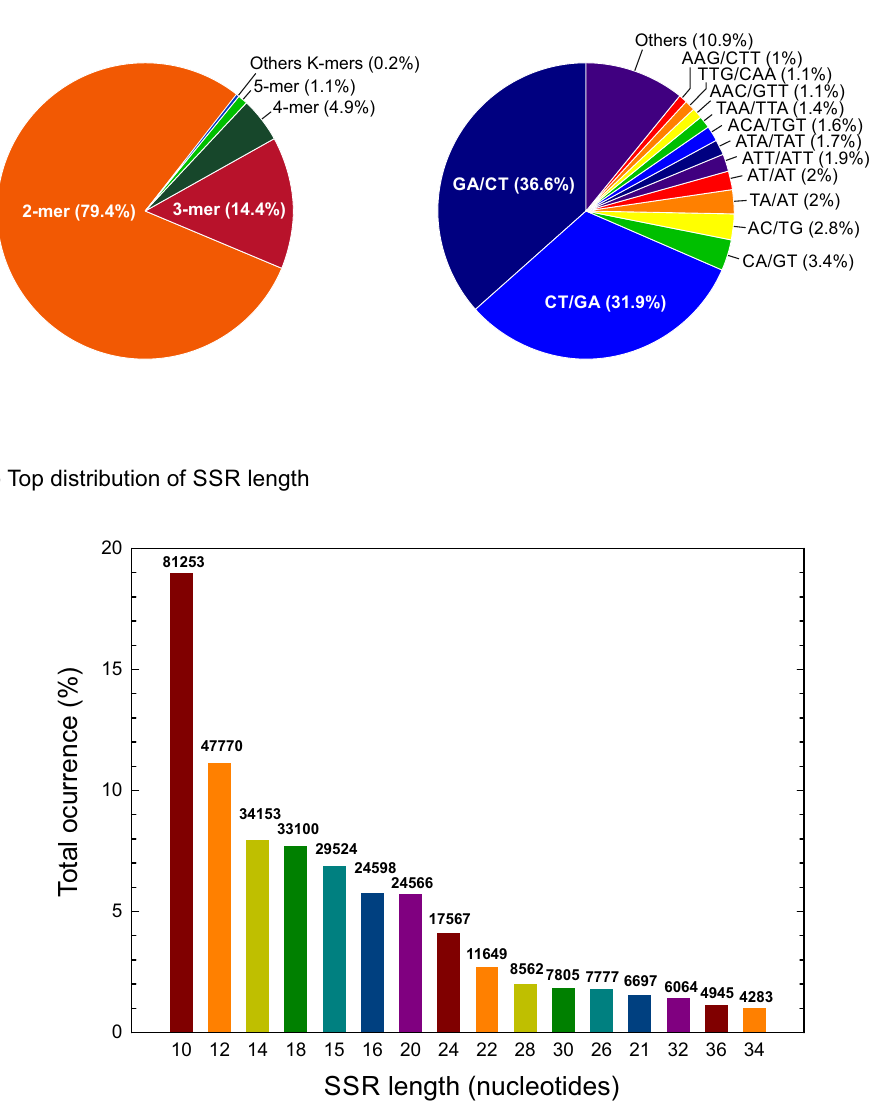
Figure 1. Frequency distribution of different classes of SSR repeat units in the Trioza erytreae genome. (A) Frequency of motif types by unit length (K-mers). (B) Frequency of grouped repeated motifs by nucleotide composition. (C) Length distribution of SSRs (total number of each type of SSR length is shown in the top of the